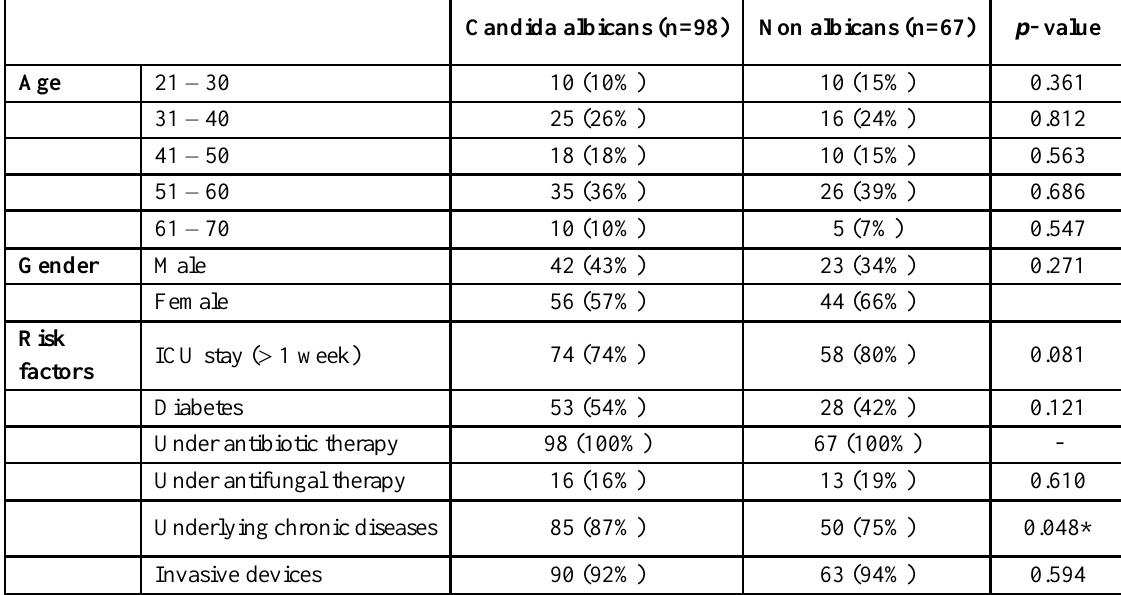
Table 1. Sociodemographic data of different clinical specimens.